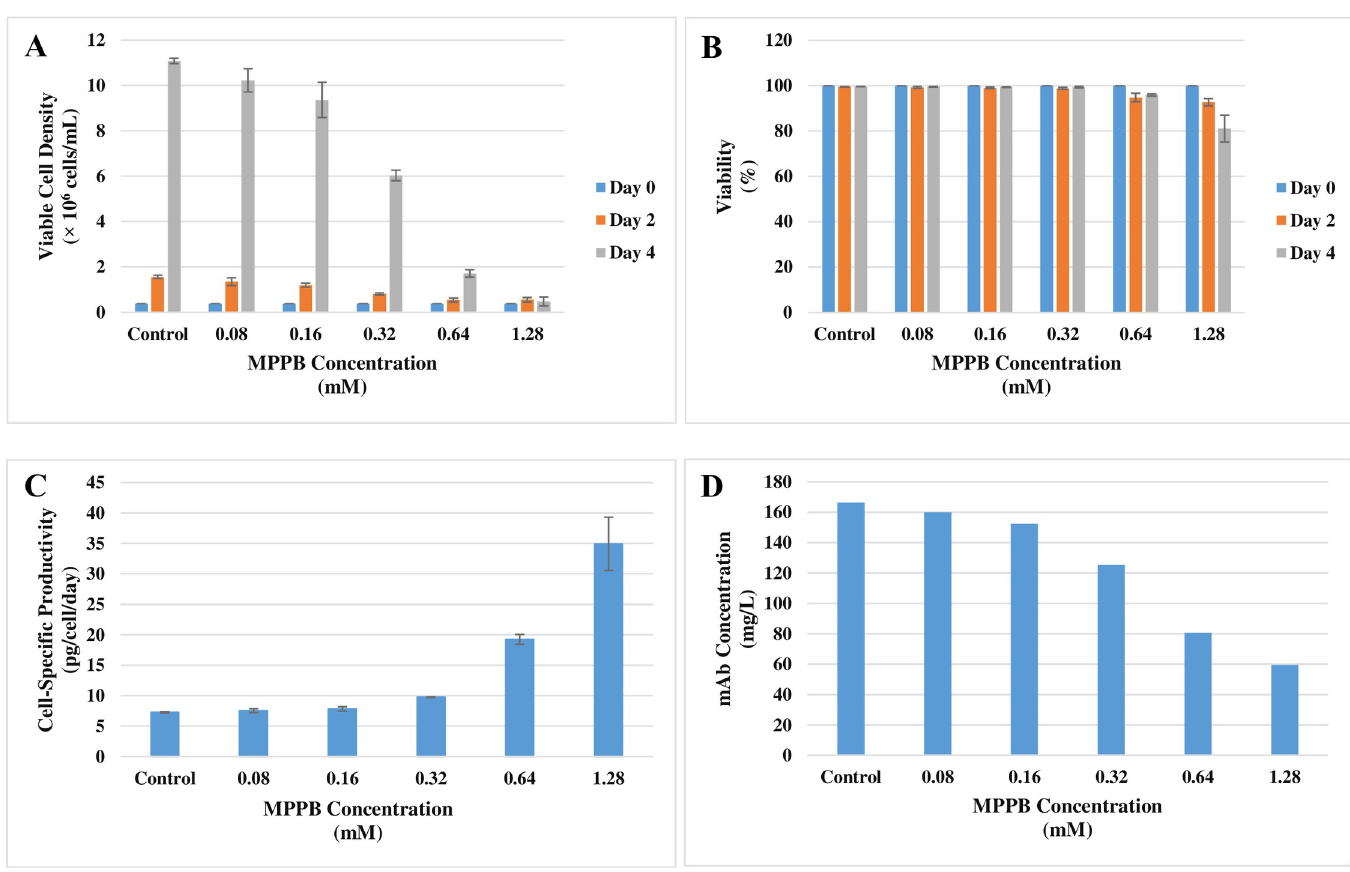
Fig 5. MPPB suppresses cell growth and increases cell-specific productivity. The tested MPPB concentrations are indicated in the figure. In these tests, viable cell density ( A ), viability ( B ), cell-specific productivity on day 4 ( C ), mAb concentration on day 4 ( D ) were evaluated.